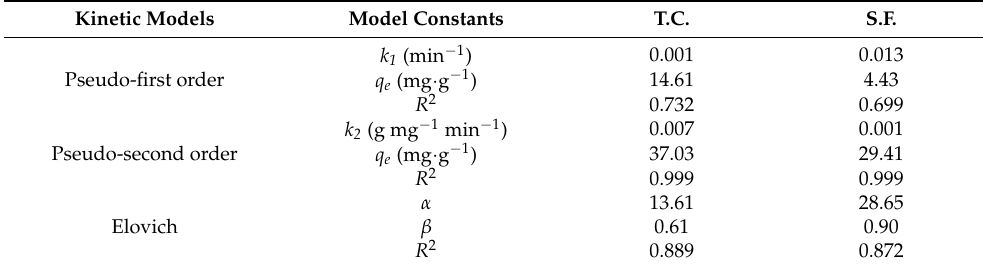
Table 1. Kinetic model constants for TC and SF adsorption using Fe-CNT-CdS.